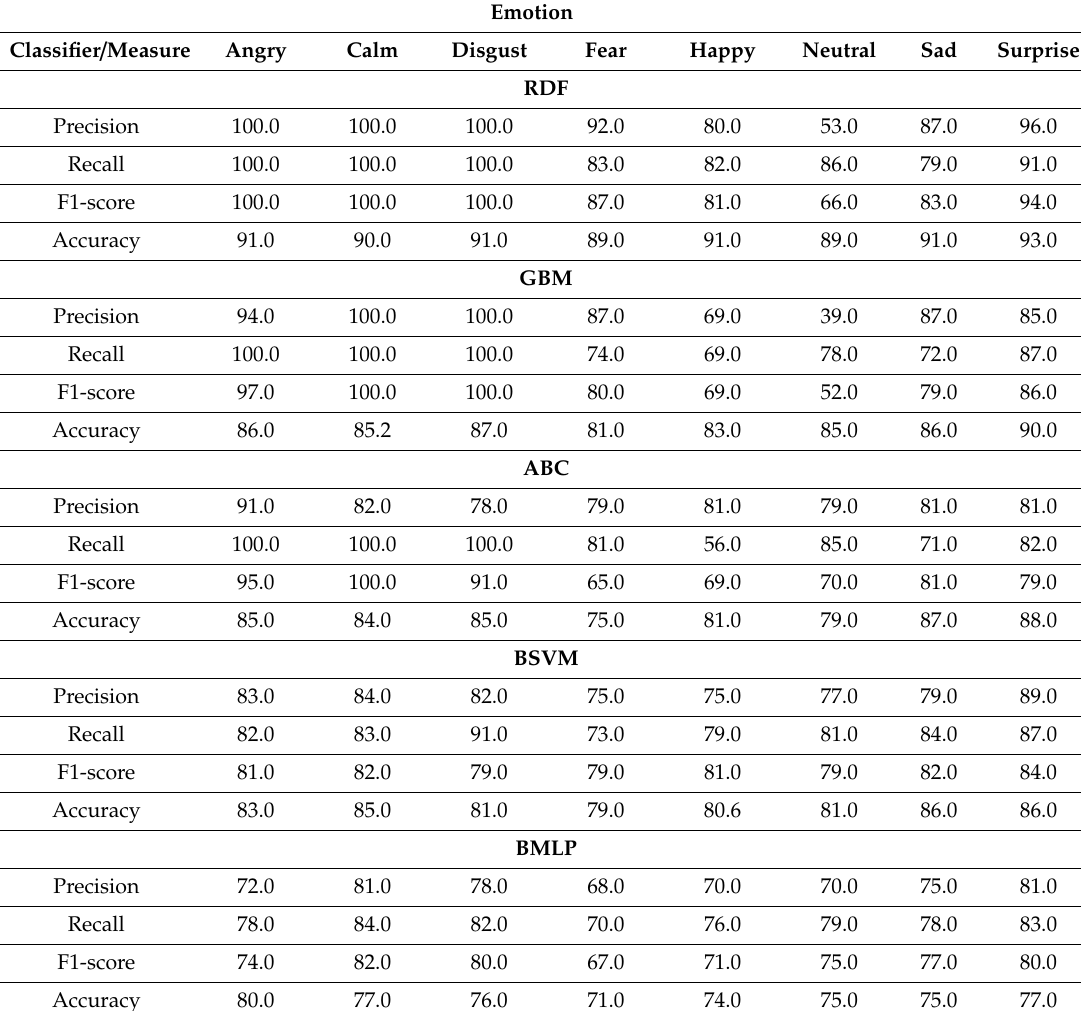
Table 5. Percentage precision, recall and F1-score and accuracy on RAVDESS